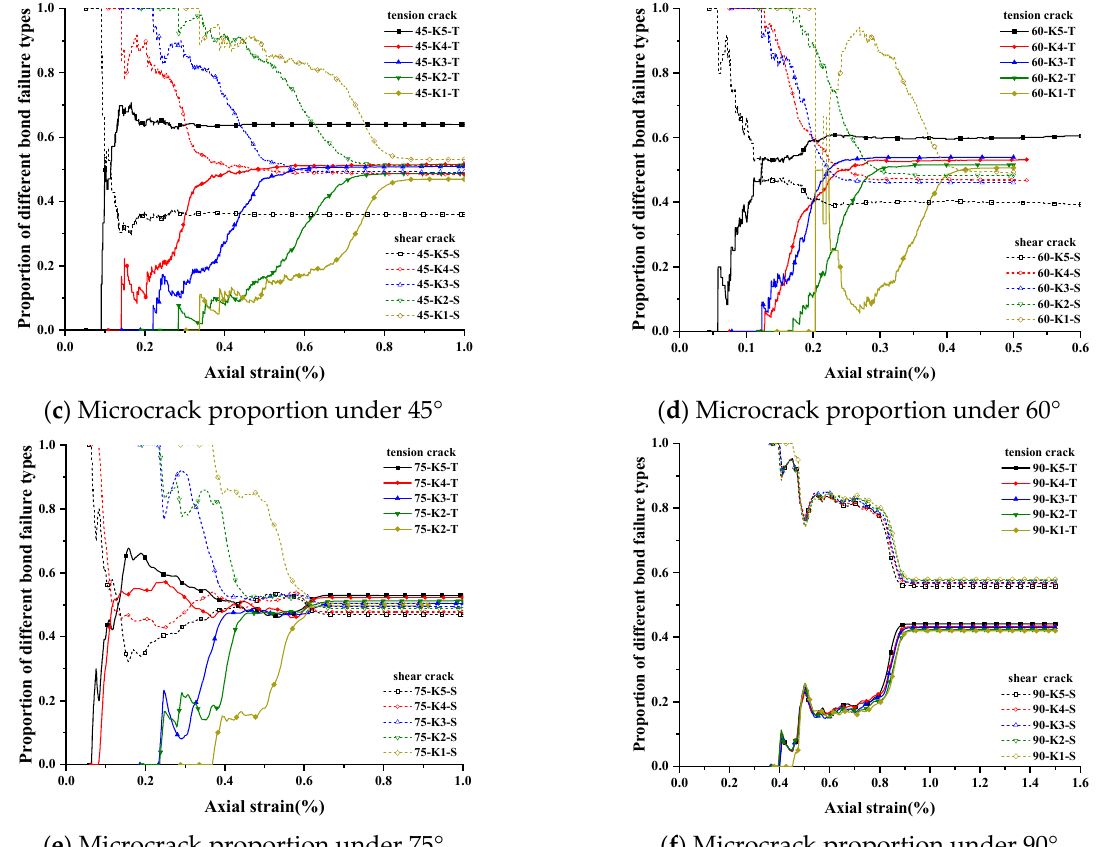
Figure 14. Microcrack proportion for jointed specimens with different inclinations and persistence.